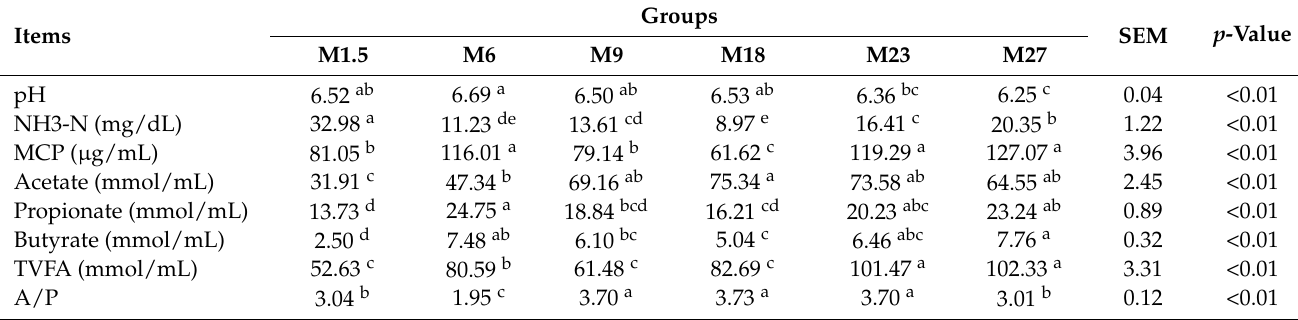
Table 1. The rumen fluid fermentation profile of dairy